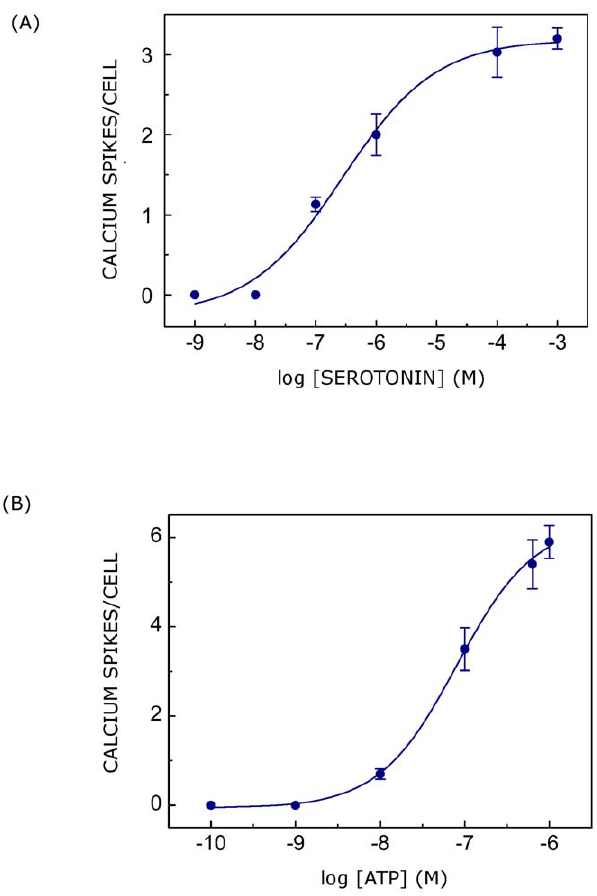
Figure 3. The maximum fold change in cytosolic calcium levels depends on ligand concentration. The figure shows calcium response in terms of maximum fold change in cytosolic calcium levels induced with either (A) serotonin or (B) ATP. Only the first spike of calcium response (when composed of multiple spikes) induced by ligands was analyzed. Data represent means 6 SEM of more than 30 cells from at least four independent experiments. See Materials and Methods for more